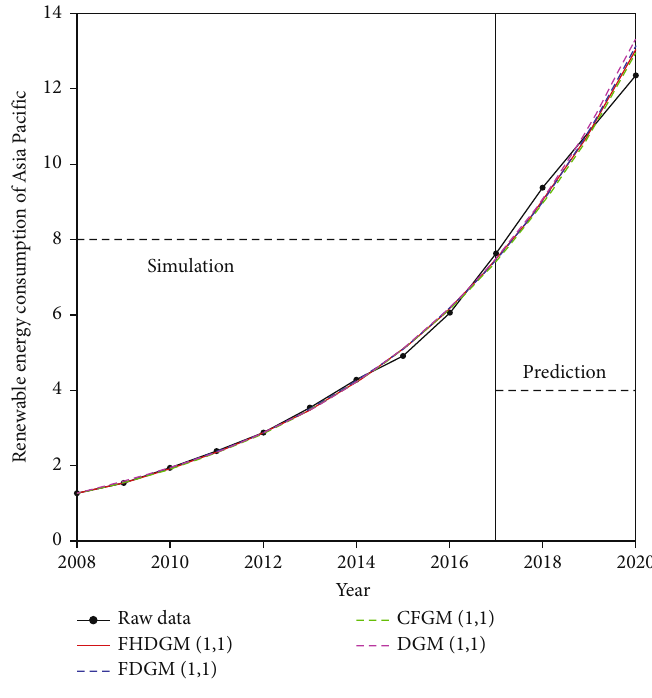
Figure 4: APE of renewable energy consumption prediction in Asia Paci fi c region.